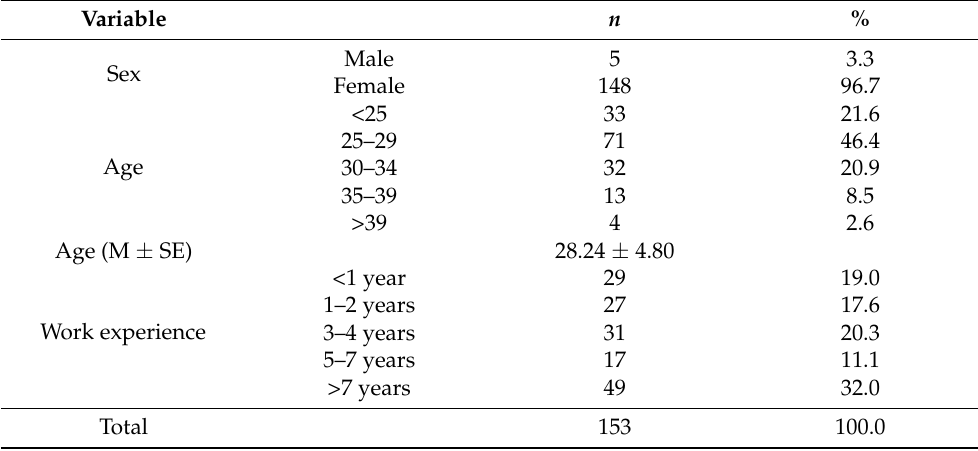
Table 2. Demographic of the dental hygienists. Unit: n ( %).